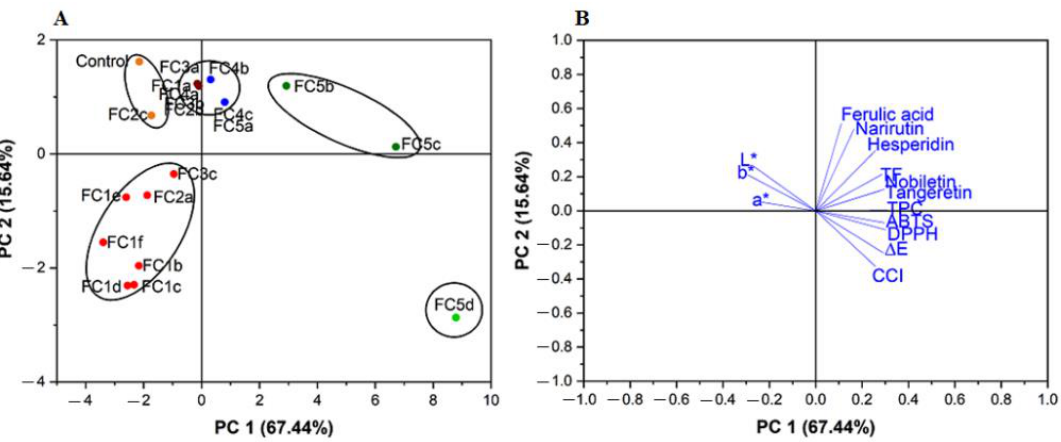
Figure 4. Principal component analysis of Citrus reticulata peels powder under Aspergillus niger GCMCC 3.6189 solid-state fermentation: ( A ) Score plots ( B ) loading plot. Tables 1 and 2 contain a detailed description of the sample names.